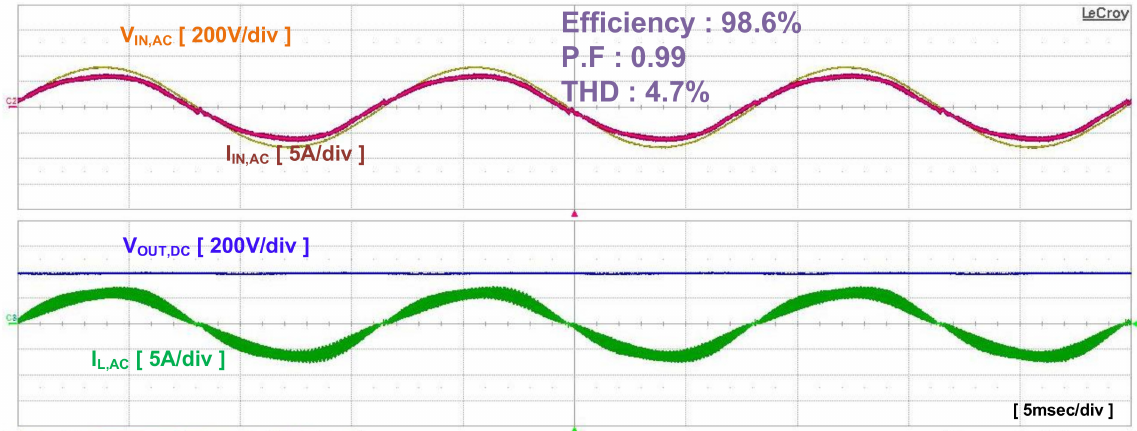
Figure 11. Steady-state waveforms at 1 kW output power.